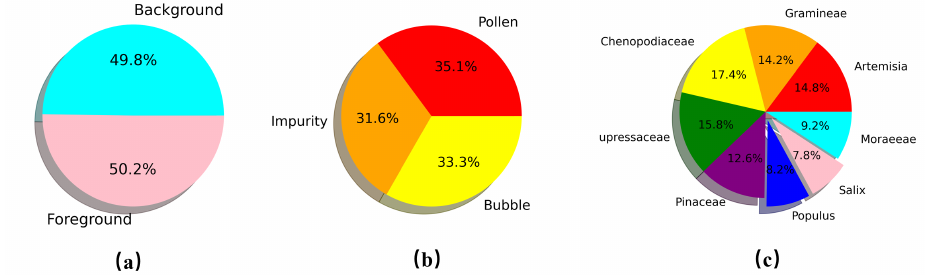
Figure 6. The data distribution of ( a ) D1, ( b ) D2 and ( c ) D3